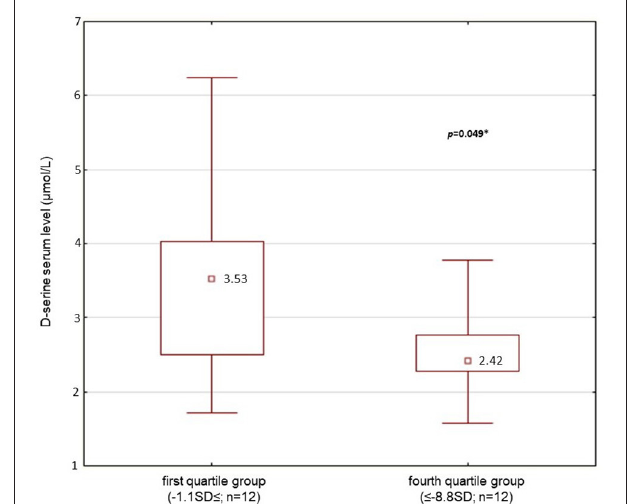
FIGURE 1 | Total serine serum level: comparison of healthy controls ( n = 50) and patients with schizophrenia ( n = 50) (box plot; * p < 0.05 was considered as significant).